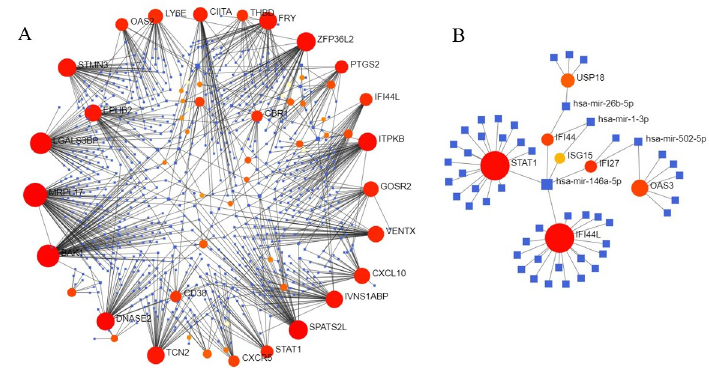
Fig 8. The miRNA-target gene network of overlapping DEGs (A) and hub genes (B) based on miRTarBase v8.0 database. Abbreviation: miRNA, microRNA, DEGs, differentially expressed